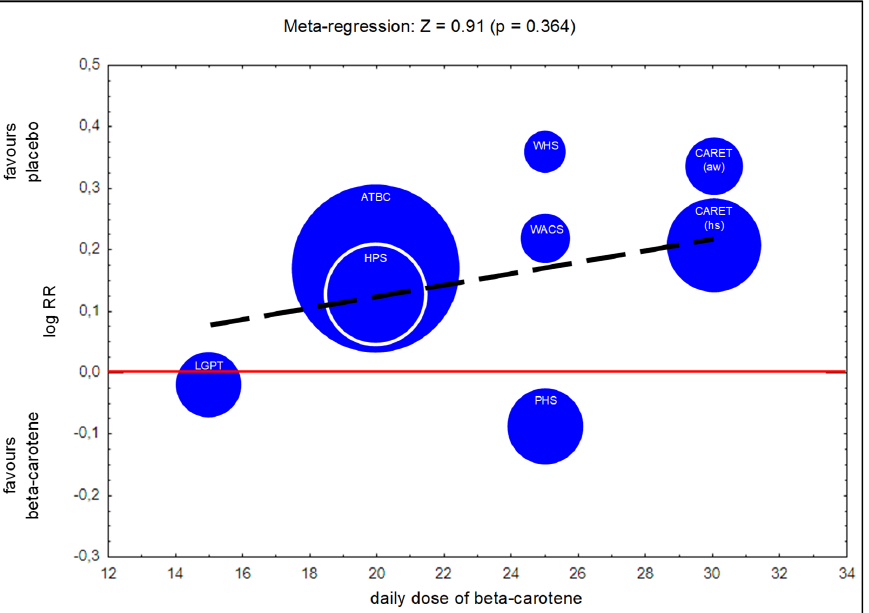
Figure 8. Meta-regression—lung cancer incidence depending on a daily dose of beta-carotene